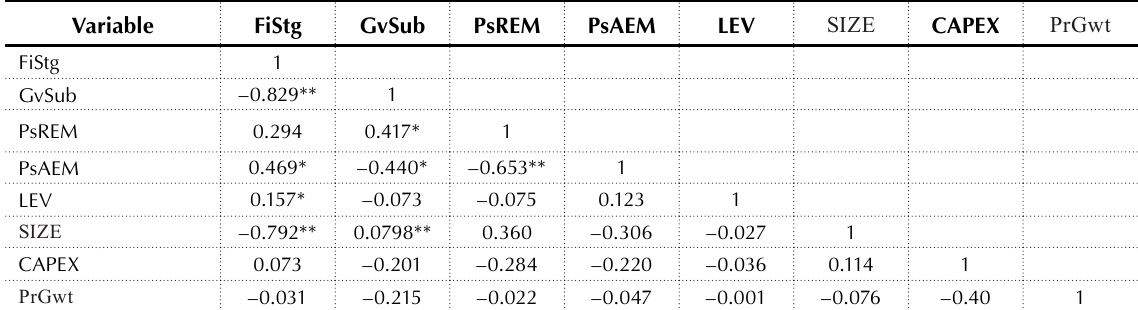
Table 3. Correlations matrix